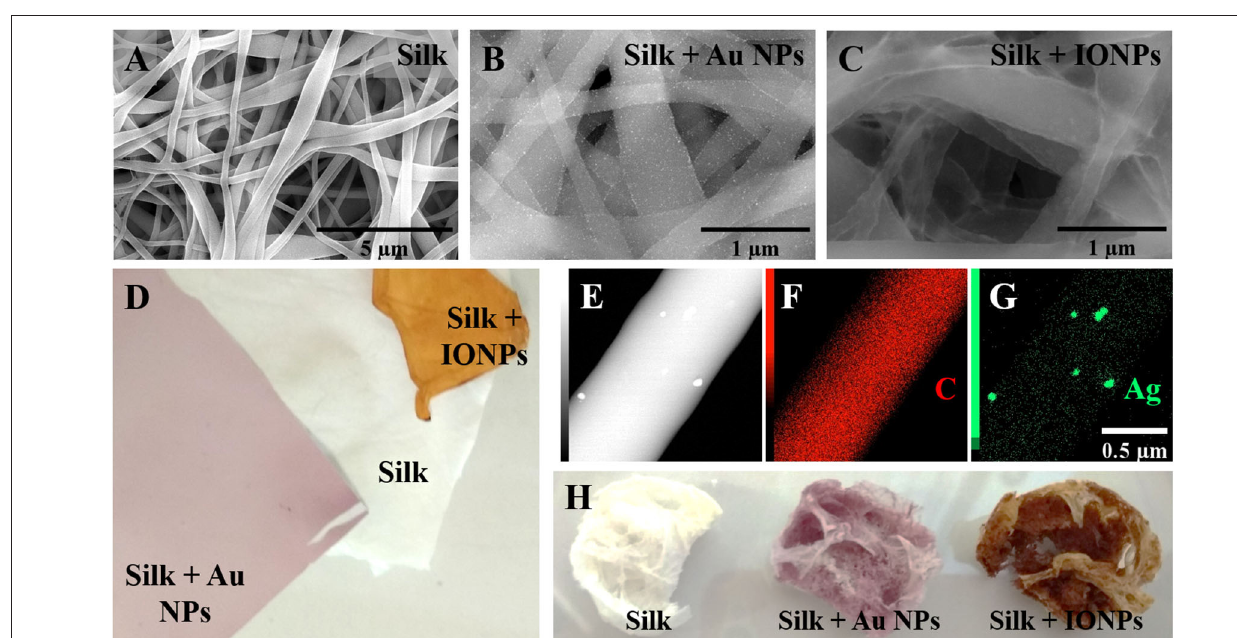
coli and Staphylococcus aureus even after 30 washes, suggesting a strong bond between the silk and silver